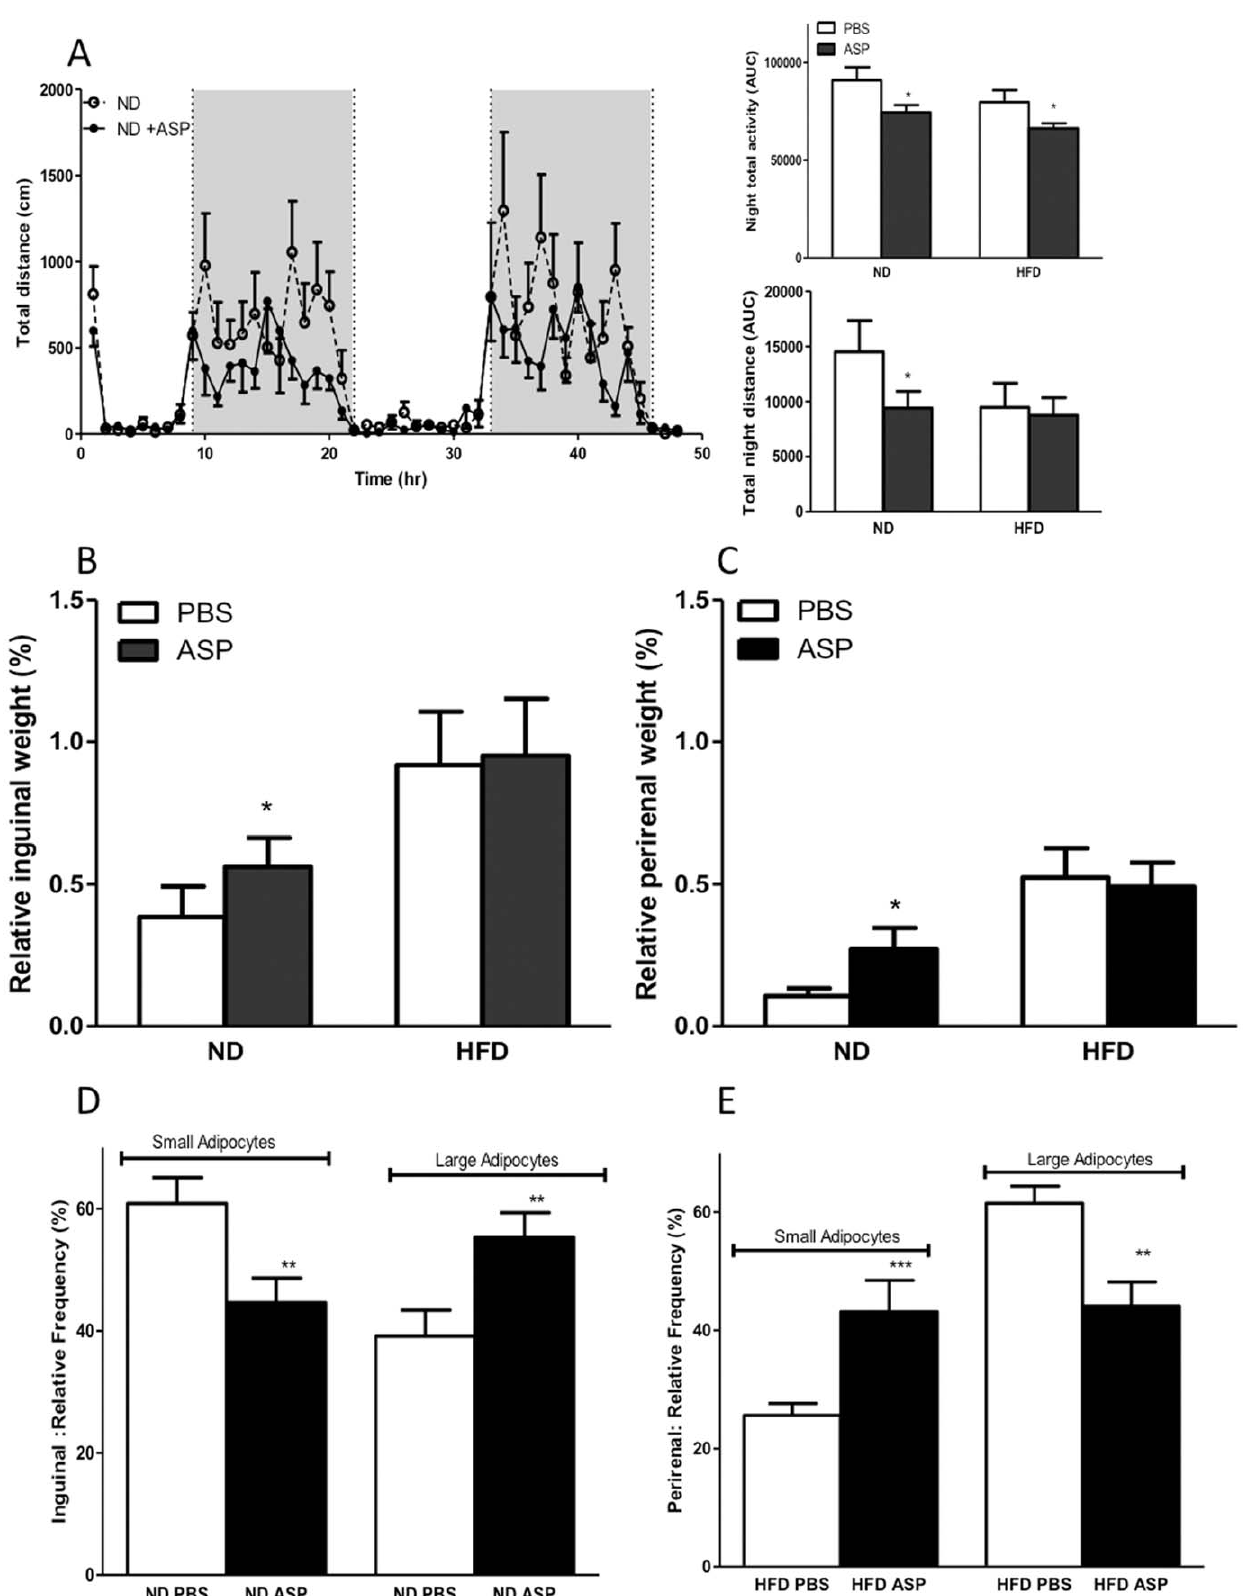
Figure 1. rASP administration alters total activity and adipose tissue. A) Activity of C3KO mice on ND 6 ASP administration measured over a 48 hour period (dark cycles are indicated as shaded areas). B and C) Relative adipose tissue mass (percent of total body weight) of C3KO or C3KO +